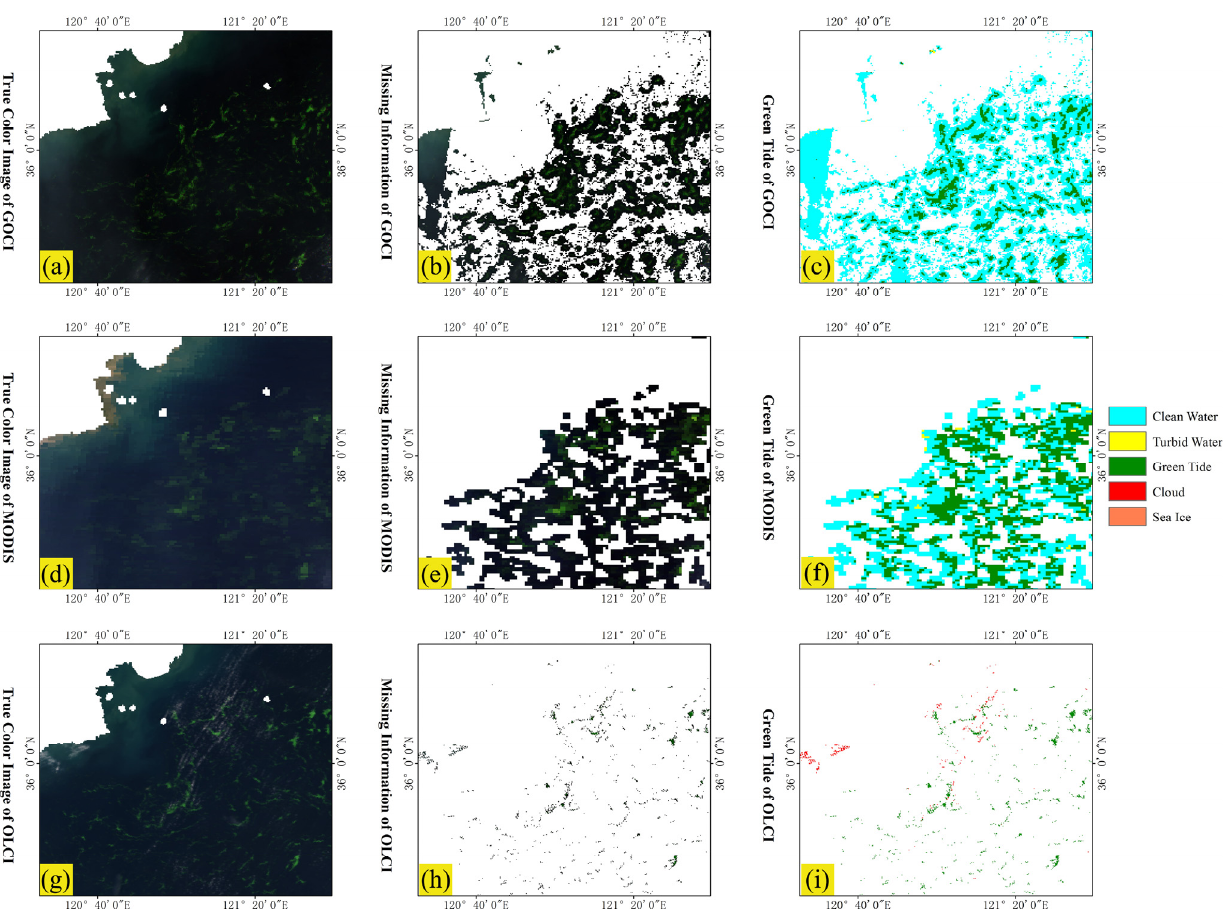
Figure 15. Schematic diagram of green tide algae in the data-free areas: ( a , d , g ) the true color images at the spatial locations of the green tide algae for GOCI, MODIS and OLCI data, respectively; ( b , e , h ) the condition of the data-free area; ( c , f , i ) the identifi-cation status of the marine objects in the data-free area.